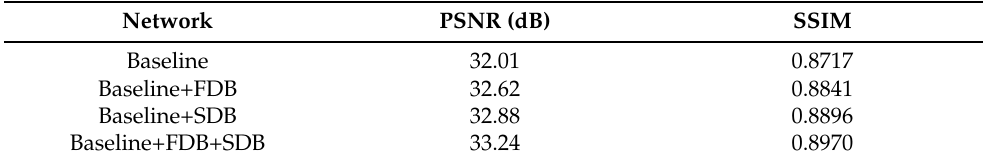
Table 2. Quantitative results of different variants of